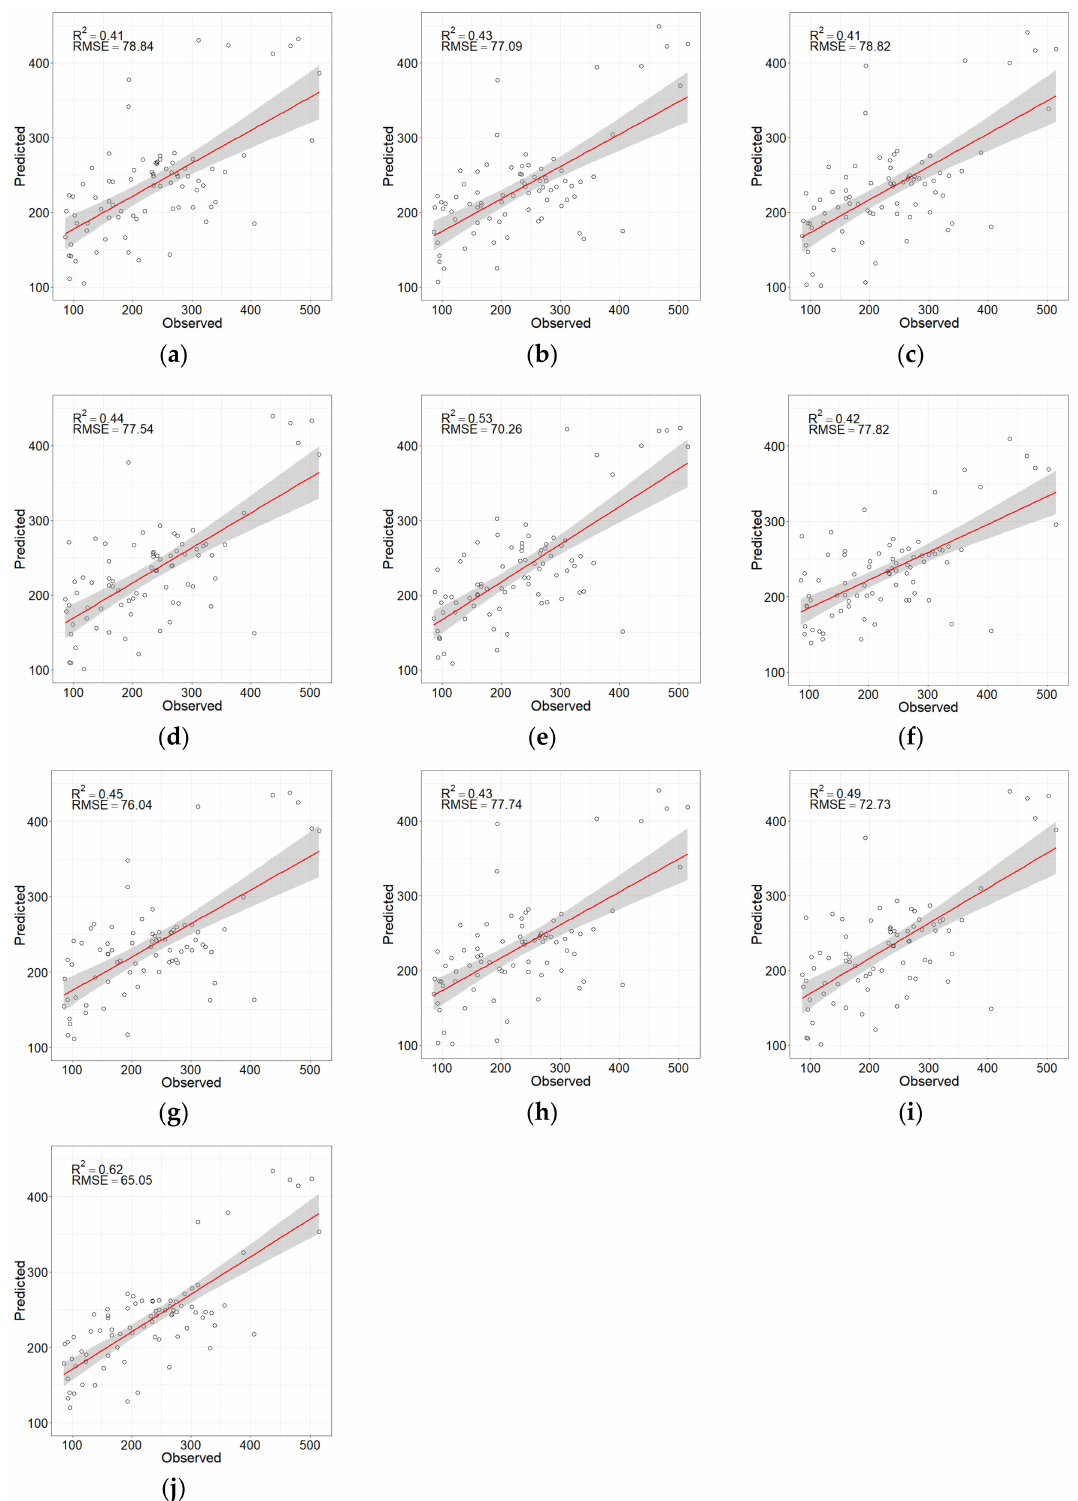
Figure 10. Scatter plots of the observed and predicted GSV values by ( a ) LSR-RFR without texture features, ( b ) RF-RFR without texture features, ( c ) Boruta-RFR without texture features, ( d ) VSURF-RFR without texture features, ( e ) SRF-RFR without texture features, ( f ) LSR-RFR with texture features, ( g ) RF-RFR with texture features, ( h ) Boruta-RFR with texture features, ( i ) VSURF-RFR with texture features, and ( j ) SRF-RFR with texture